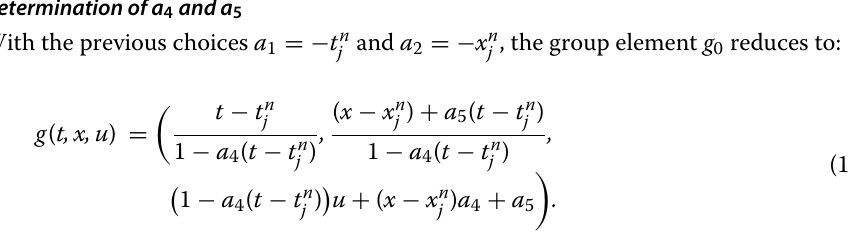
Determination of a 4 and a